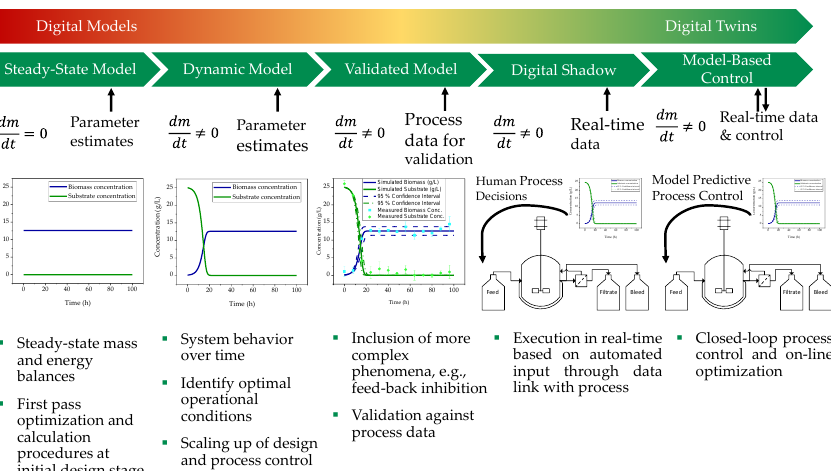
Figure 2. Levels of a digital twin depending on model depth and the amount of information exchanged with the physical process. From a simple steady-state model to a fully developed digital twin for model-based control [39].